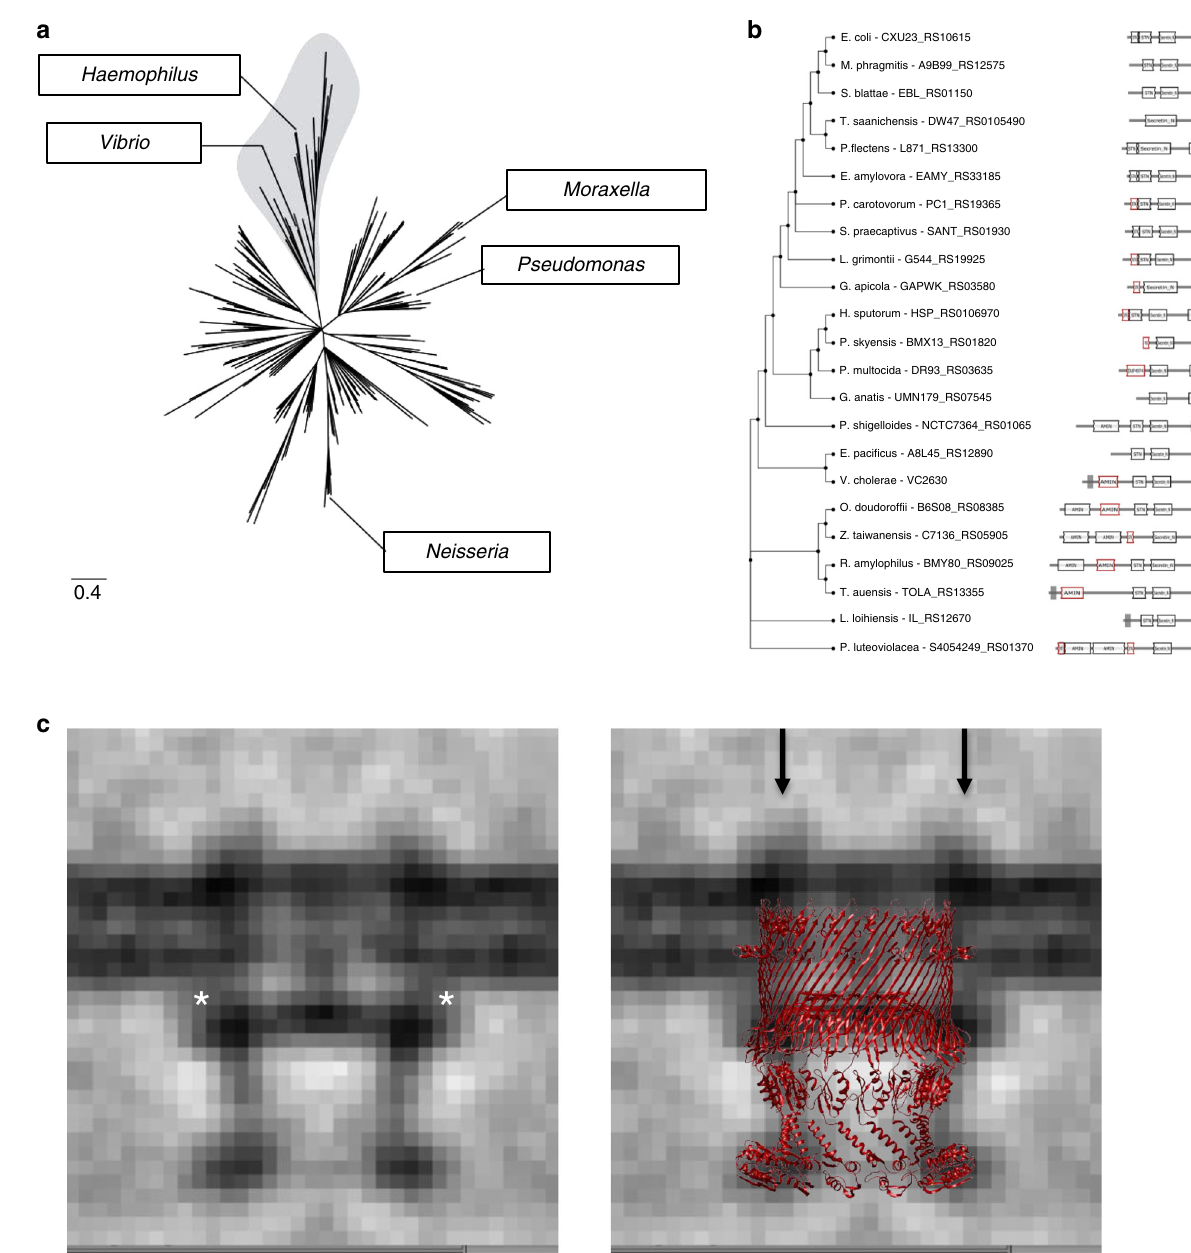
Fig. 4 The domain architecture diversity of T4aP secretins and a comparison of VcPilQ with the sub-tomogram average of M. xanthus type IVa pilus machinery. a Phylogenetic inference of the secretin domain in a representative set of 197 secretins in Proteobacteria. The shaded region is a fully resolved part of the tree that includes the VcPilQ and is displayed in details in panel ( b ). The locations of representatives of the Haemophilus, Moraxella, Myxococcus, Neisseria, Pseudomonas , and Vibrio genera are indicated. b Detail of the branch that includes the V. cholerae (Vc) secretin with domain architecture for each representative sequence. The domains were identi fi ed using Comprehensive Domain Visualization Tool (CD-VIST) pipeline by fi rst executing a HMMER search (a hidden Markov model package) (black) and subsequently by a HHblits (HMM – HMM-based lightning-fast iterative sequence search) search (red), while transmembrane regions were predicted using the TMHMM (transmembrane hidden Markov model) package (gray region) 141 . The tree and the gene neighborhood information is available in Supplementary Data 1 – 3. c VcPilQ is compared to the non-piliated sub-tomogram average of the type IVa pilus machinery in the Δ pilP Myxococcus xanthus strain (EMD-3249) 49 . In the Δ pilP strain, only PilQ and TsaP are present in the complex. The putative TsaP location is marked with an asterisk in the left image. In the right image, the structure of VcPilQ (dark red) is aligned to the sub-tomogram average. Arrows indicate unidenti fi ed extracellular